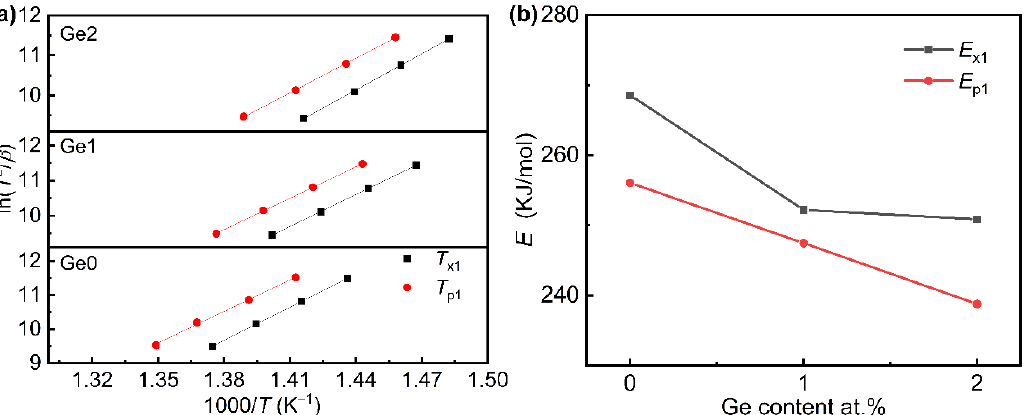
Figure 5. Kissinger plots for the T x 1 and T p1 ( a ) and the changes in the activation energies determined from Kissinger plots with the alloy composition ( b ) of the as-spun Fe 80.2 Si 3 B 12- x P 2 Nb 2 Cu 0.8 Ge x ( x = 0, 1, 2 at.%) alloy ribbons. Table 1. Thermal parameters and the activation energies calculated using the Kissinger equation